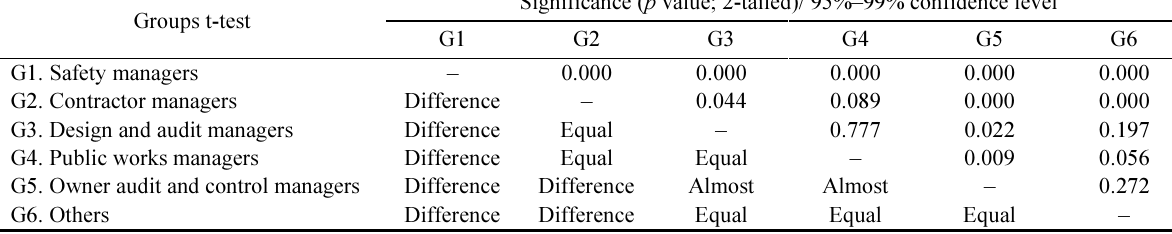
Table 10. Significance of group